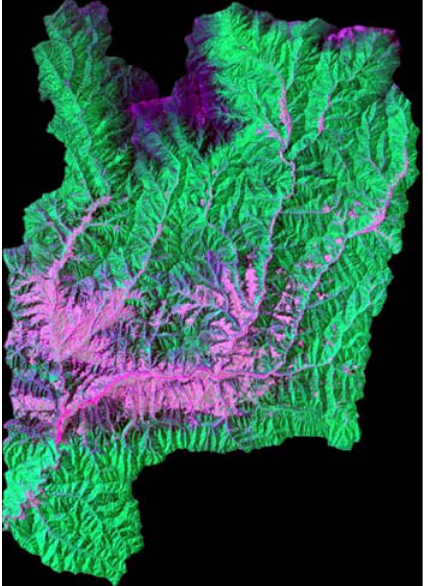
Figure 2. Color composite of RGB-543 Landsat-7 ETM+ image of the study watershed before topographic correction.